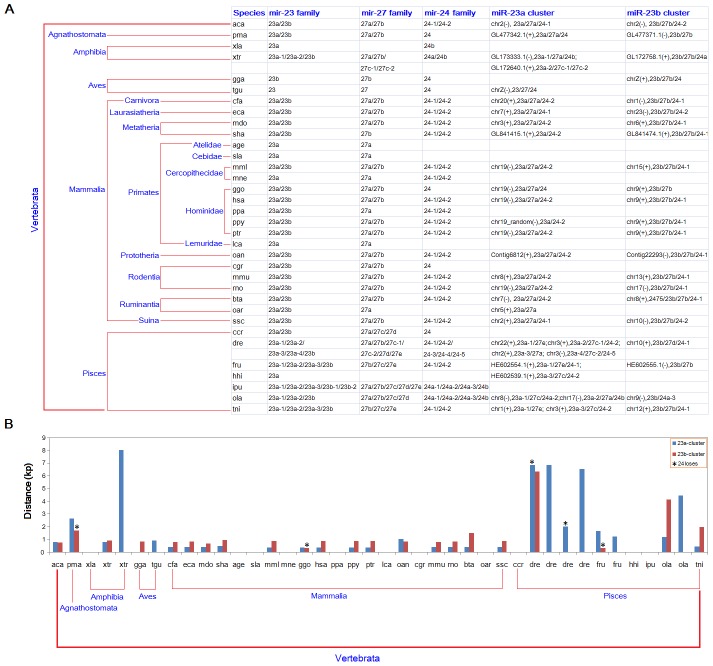
Evolutionary taxa, related miRNA members and physical distance of gene cluster in different animal species.(A) The three miRNA gene families have been detected in vertebrates. Their members are prone to be clustered on specific genomic region. Blank in columnn of gene family indicates that the miRNA members are not detected or predicted; blank in columnn of gene cluster indicates that no location annotation based on the current database. (B) Distribution of the physical distance between clustered miRNAs (miR-23a cluster and miR-23b cluster). The label of “24 loses” indicates that miR-24 is not detected in the species. As a terminus miRNA gene in gene cluster, the loss of miR-24 will influence the physical distance of the miRNA gene cluster.